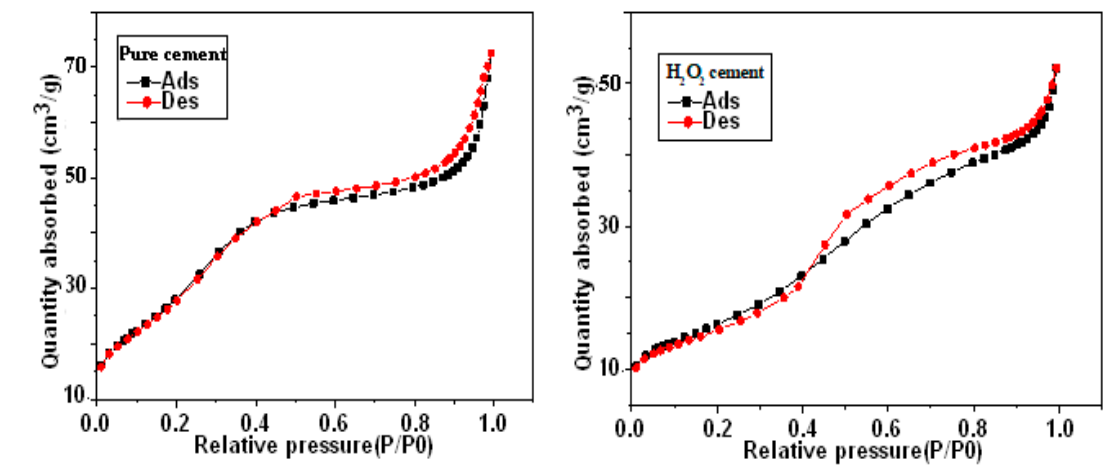
Figure 2. N2 adsorption/desorption curve for pure and H 2 O 2 cements.